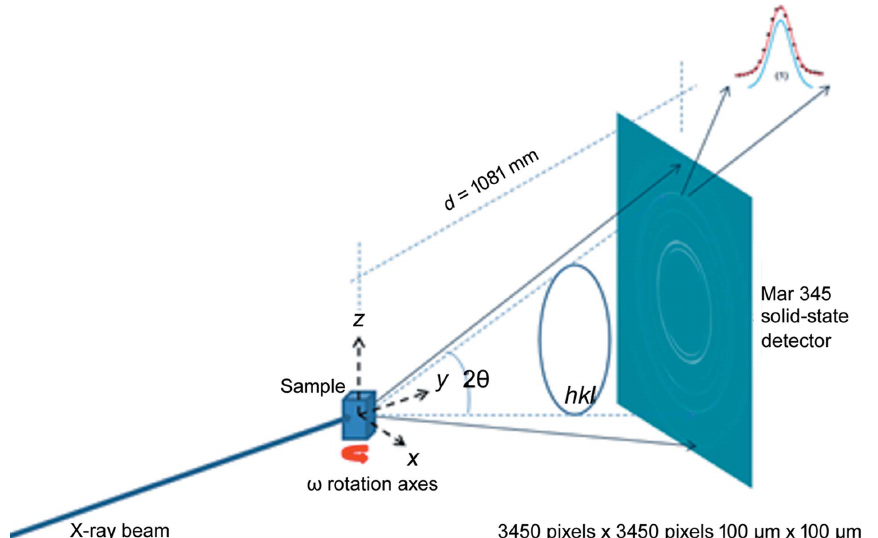
Figure 1 Transmission synchrotron X-ray Debye–Scherrer rings taken at HEMS at Petra III/DESY. Beam size: 100 m m (cid:4) 100 m m, (cid:2) = 0.14235 A˚ . The Mar345 detector ensured a minimum of 20 measured points for the whole breadth for each of the measured peaks, while the Perkin–Elmer detector allowed measurement of approximately 10